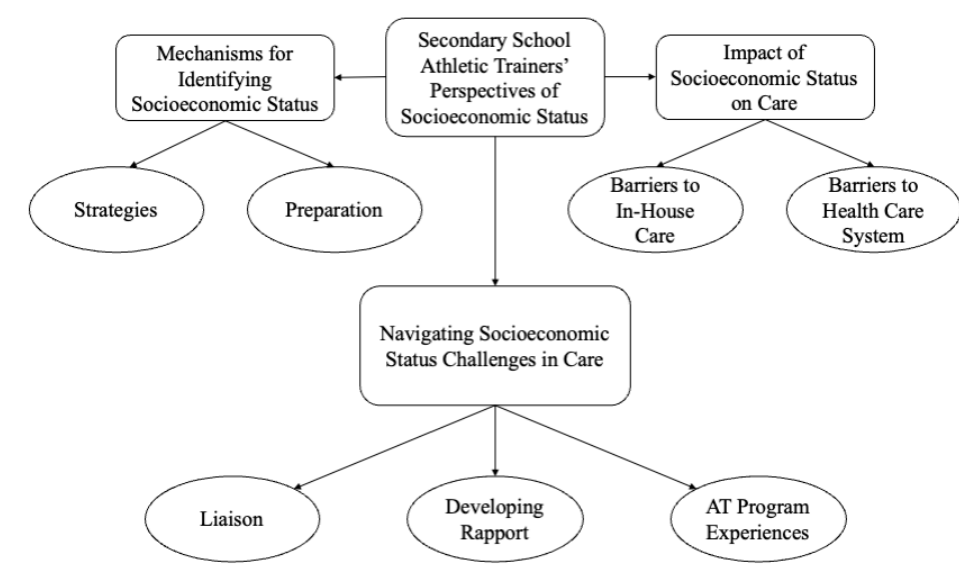
Figure Figure 1. Secondary School Athletic Trainers’ Perspective of Socioeconomic Status Themes and Sub- themes .